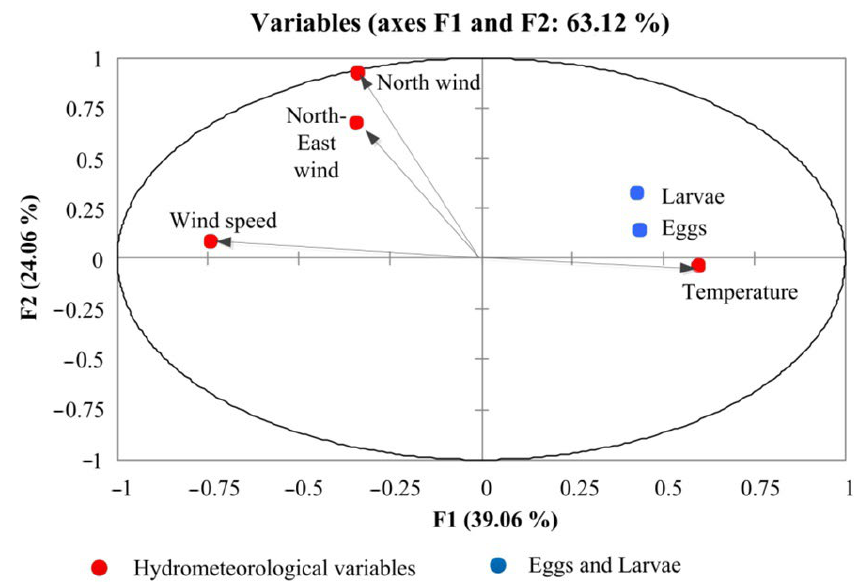
Figure 5. Correlation biplot diagram based on the principal component analysis (PCA) of the hydrometeorological variables and abundance of ichthyoplankton.